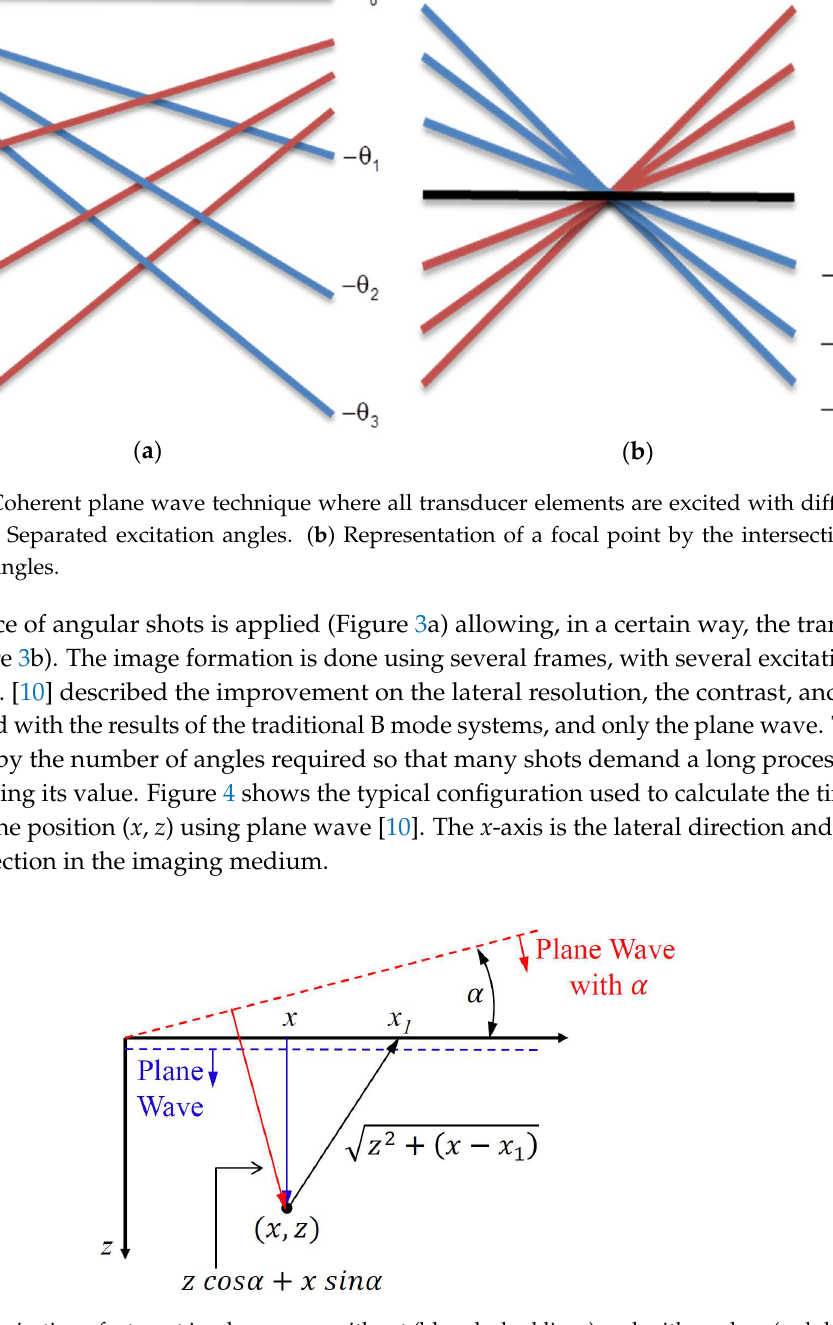
Figure 4. Projection of a target in plane wave without (blue dashed lines) and with angle α (red dashed lines) (Adapted from [10]).